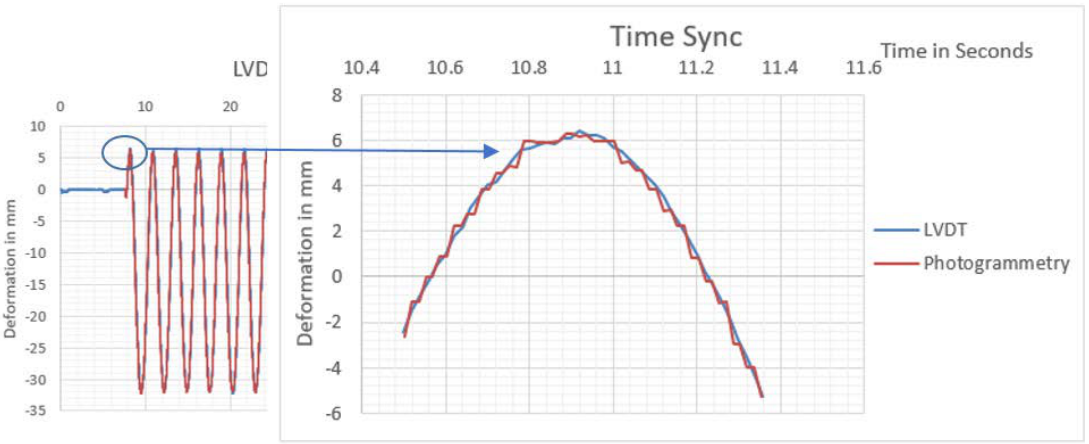
Figure 10. Time-domain synchronization between LVDT and photogrammetry measurements.